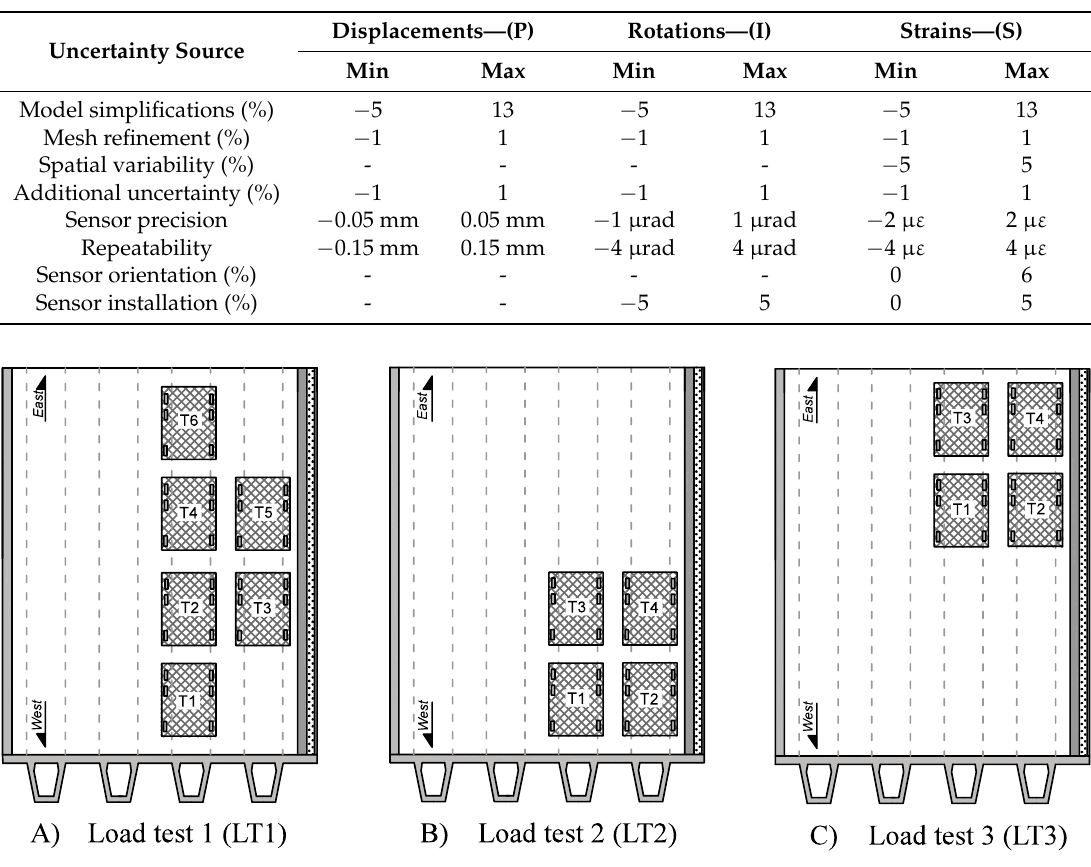
Table 2 . Modelling and measurement uncertainties. Table 2. Modelling and measurement uncertainties.